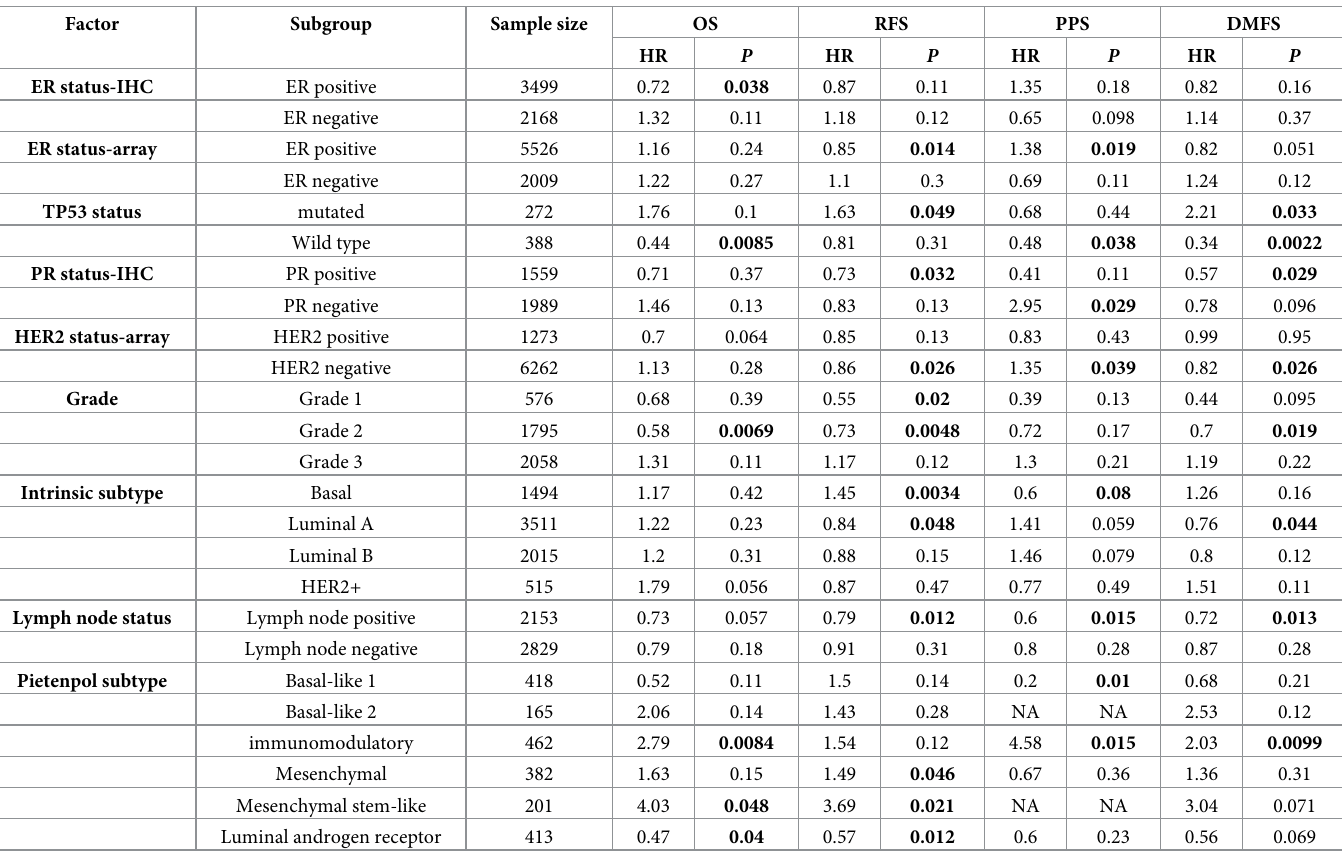
Table 1. Subgroup analysis on the correlation of SMARCA1 expression and prognosis of breast cancer cases.